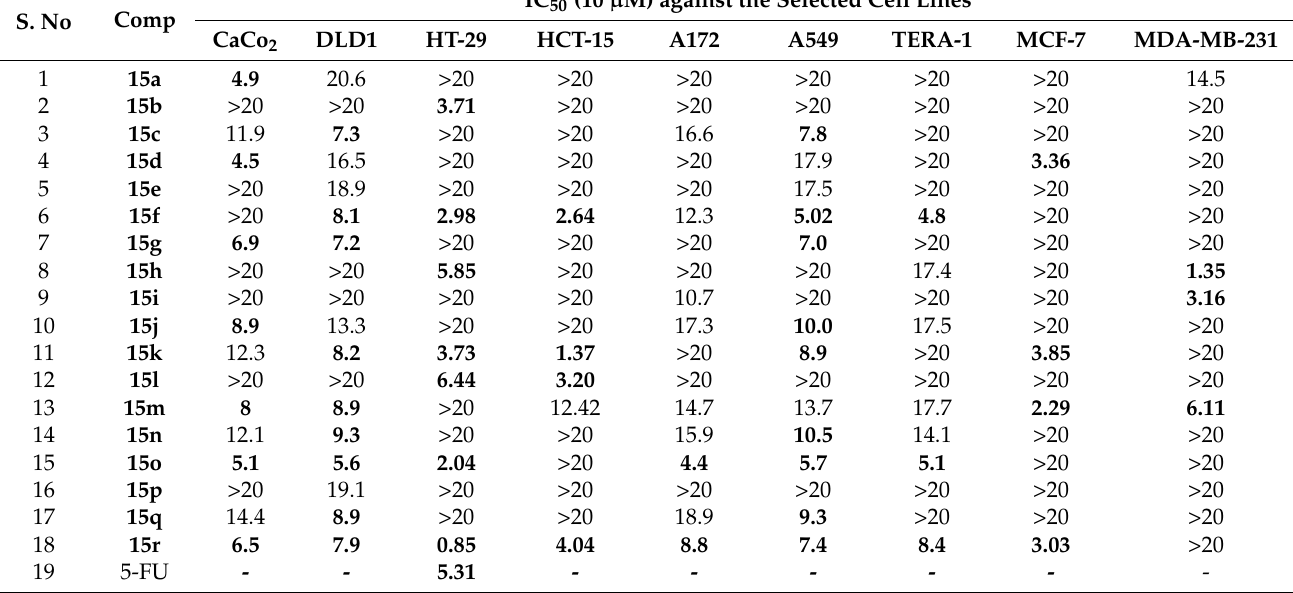
The 50% inhibitory concentrations were the average values of three individual experiments in MCF-7 (breast cancer cell line), MDA-MB-231 (triple-negative breast cancer (TNBC) cell line), HT-29 , DLD1 , and CaCO 2 (human colorectal adenocarcinoma cell line), HCT-15 (human colon adenocarcinoma colorectal adenocarcinoma), lung adenocarcinoma A549, glioblastoma, brain cancer A172, teratocarcinoma and testicular cancer TERA-1, and NRK 52E (normal rat kidney